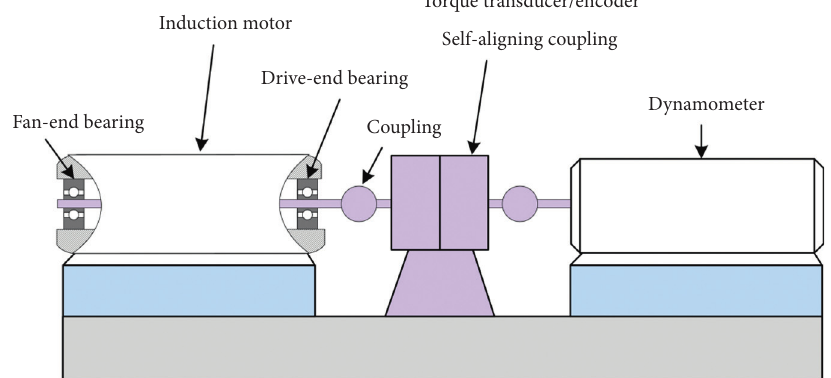
Figure 8: Bearing failure simulation test